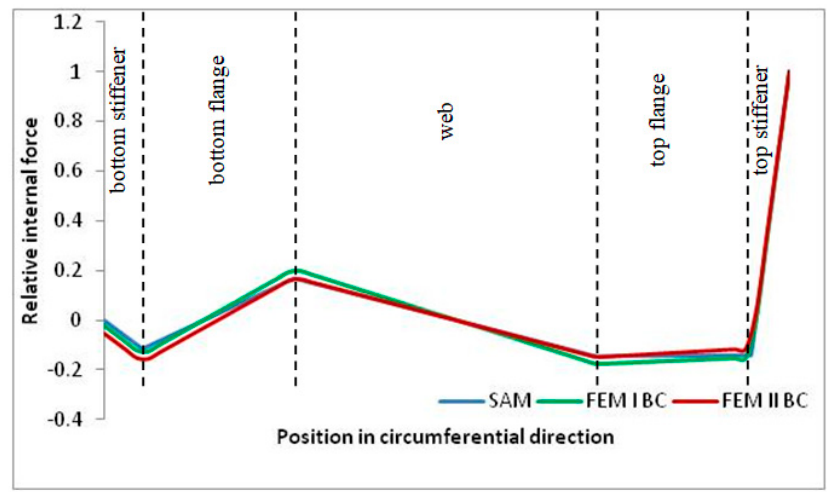
Figure 4. The distribution of N x internal force in LC–1 beam cross-section for the primary global distortional–lateral buckling mode.